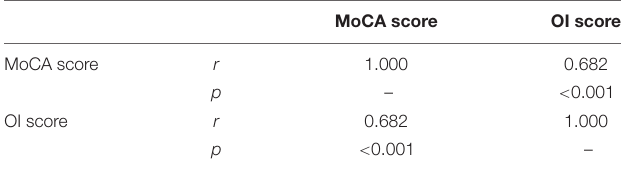
TABLE 3 | Correlation between MoCA score and OI score.